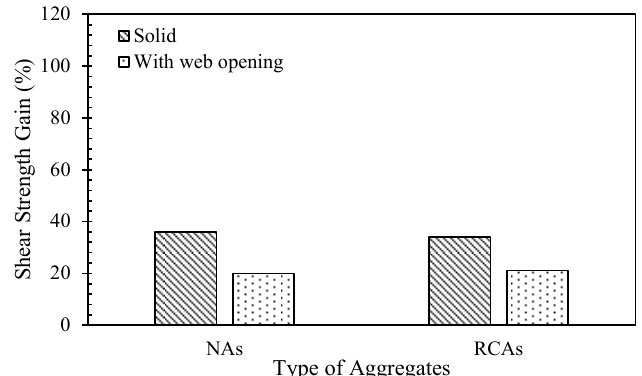
Figure 24. Shear strength gain of models with minimum stirrups with and without openings.